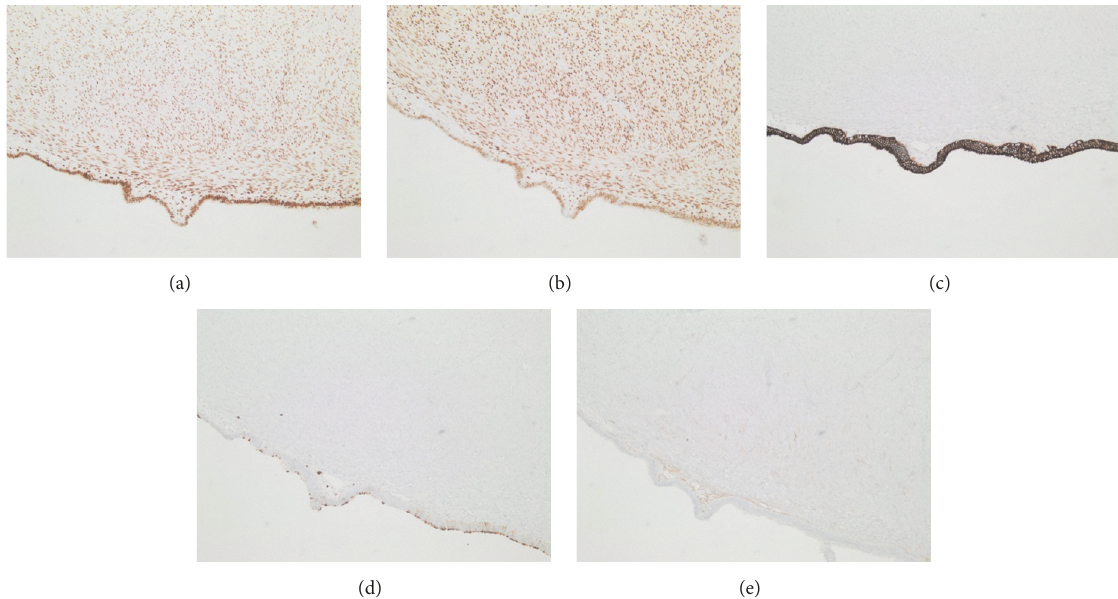
Figure 3: Immunohistochemical analysis stained (100x) (a) strongly positive for estrogen in epithelial and stromal cells, (b) strongly positive for progesterone receptor in epithelial and stromal cells, (c) strongly positive for CK7 in epithelial cells, (d) focally positive for CD15, and (e) positive for CD10 in the cytoplasm of stromal